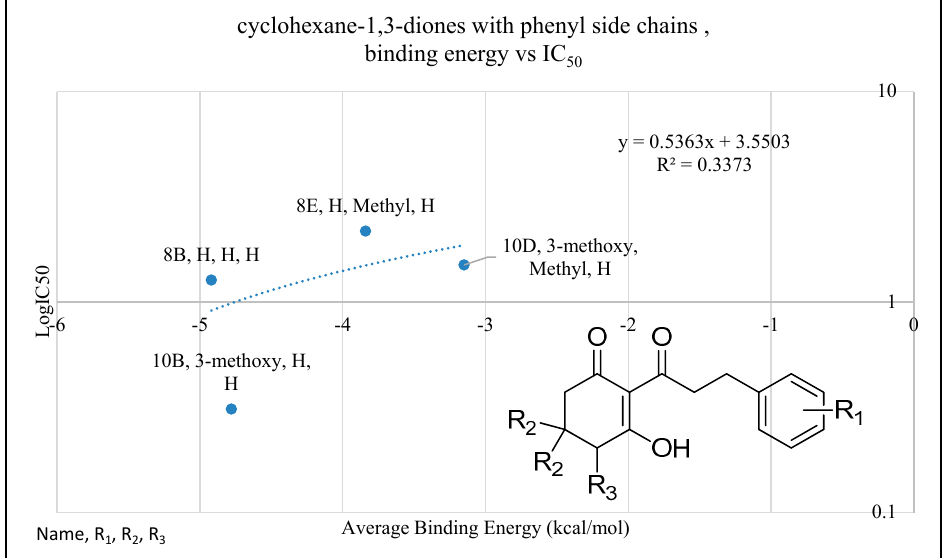
Figure 8. The relationship of binding energy and the log I 50 of a selection of cyclohexane-1,3-diones with phenyl side chains. Molecules are organized according to class of base structure (Grouping), seen on the bottom right. Each data label follows the pattern of “Name, Grouping, R 1 , R 2 , R 3 ”, where “R 1 , R 2 and R 3 ” refer to the functional